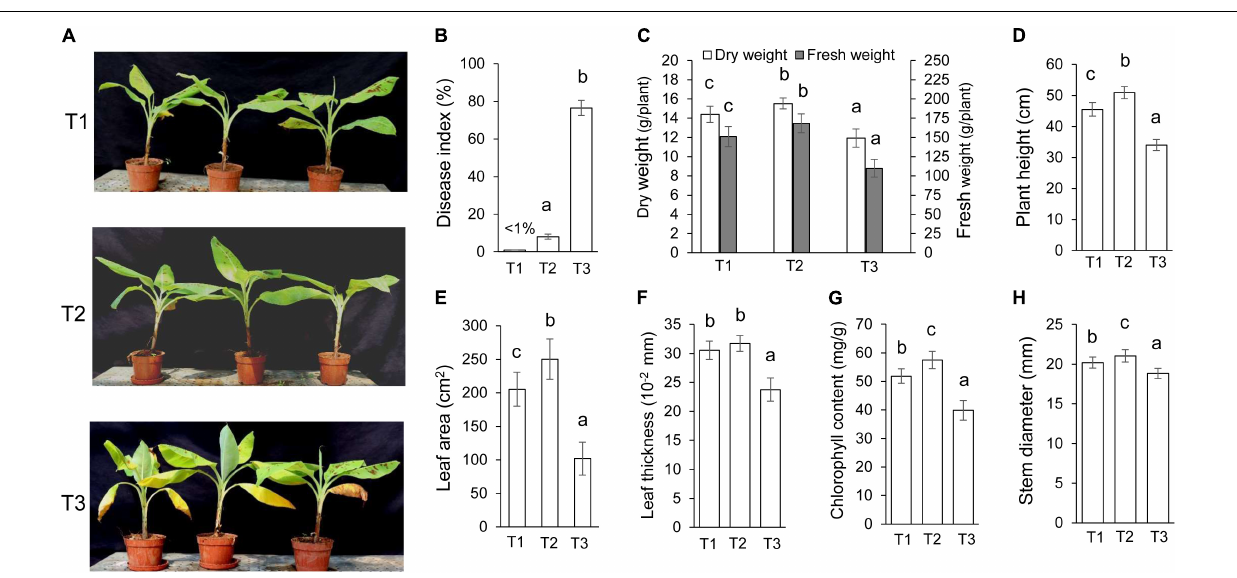
FIGURE 5 | Assay of chlorotic symptoms and plant growth promotion after treatment with Streptomyces BITDG-11 at 45 dpi. T1: medium treatment, T2: Streptomyces BITDG-11 + F. oxysporum TR4 treatment; T3: F. oxysporum TR4 treatment. (A) Chlorotic symptoms of banana plantlets in different treatment groups. (B) Quantitative analysis of disease indexes in different treatment groups. Measurement of physiological indicators including plant dry and fresh weight (C) , plant height (D) , leaf area (E) , leaf thickness (F) , chlorophyll content (G) , and stem diameter (H) in different treatment groups. Error bars indicated standard errors of the means of three repeated experiments. Different letters indicated a significant difference in comparison with the treatment group of F. oxysporum TR4 (LSD’s multiple range test, p <